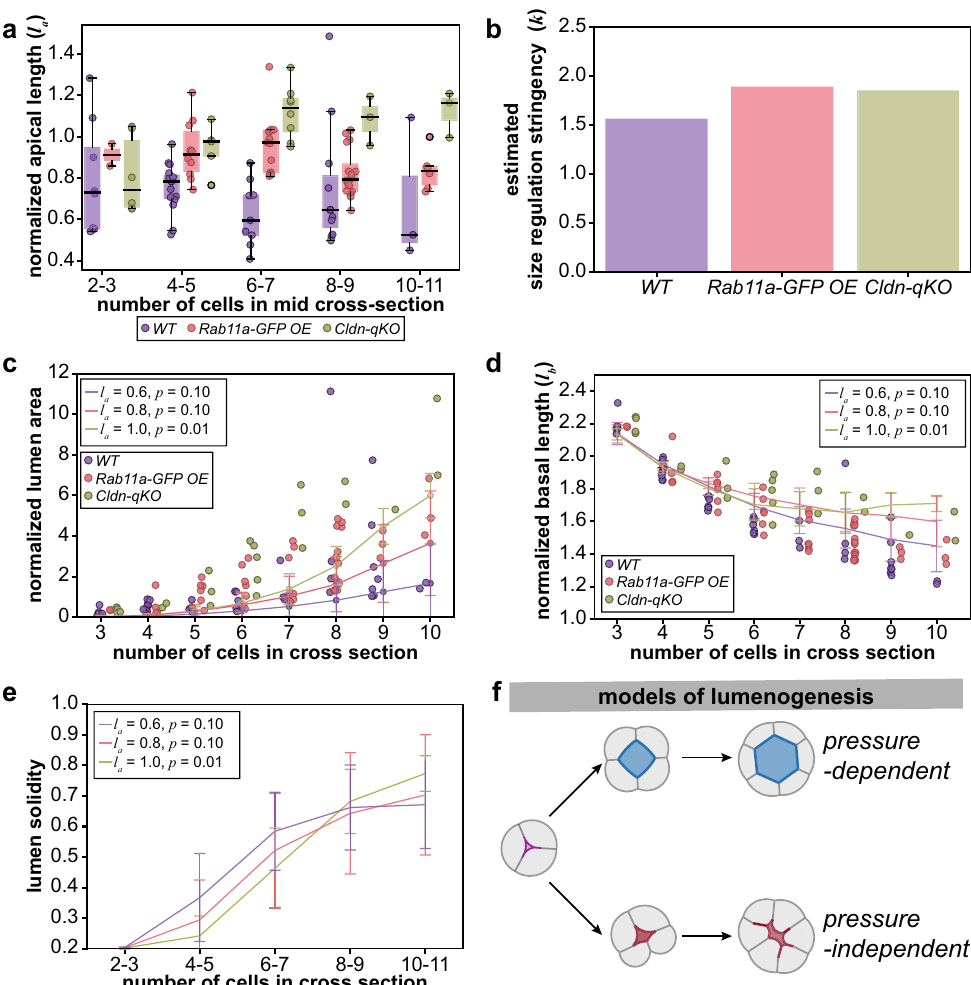
Fig. 6 Comparison of model to experimental data. a , b Estimates were obtained from data for the parameters normalized apical length ( l a ) ( a ) and size regulation stringency ( k ) ( b ) as described in “ Methods ” section. The parameters p and l b were free parameters and tuned to agree with data, with the constraint that p for the Cldn-qKO condition was ten-fold smaller than for the other two conditions. c , d Normalized lumen cross-sectional area ( c ) and normalized mean basal length ( d ) and as a function of size for WT, Rab11a-GFP OE, and Cldn-qKO spheroids. Model predictions (lines) show good quantitative agreement with experimental data (points). Welch ’ s two-sided t -test with Coarsened exact matching (CEM) for cross-sectional lumen area for WT vs. Rab11a-GFP OE p = 0.7, WT vs. Cldn-qKO p = 5 × 10 − 4 . Welch ’ s two-sided t -test with CEM for basal length for WT vs. Rab11a-GFP OE p = 0.9, WT vs. Cldn-qKO p = 9 × 10 − 6 . Welch ’ s two-sided t -test with CEM for simulation cross-sectional area with l a = 0.6 vs. 0.8, p = 0.06; l a = 0.6 vs. 1.0, p = 8 × 10 − 4 . e Plot of model predictions of lumen solidity as a function of number of cells. Welch ’ s two-sided t -test with CEM for simulation cross-sectional area with l a = 0.6 vs. 0.8, p = 0.50; l a = 0.6 vs. 1.0, p = 0.38. f Schematic depicting pressure-dependent and pressure-independent lumenogenesis. For plots a , c , and d n = 51 WT, 51 Rab11a-GFP OE, and 25 Cldn-qKO conditions. Error bars on lines indicate standard deviation for simulation results, center of error bars on lines indicate mean of simulation results, for n = 25 simulations for plots c , d , and e . Source data are provided in the Source Data fi